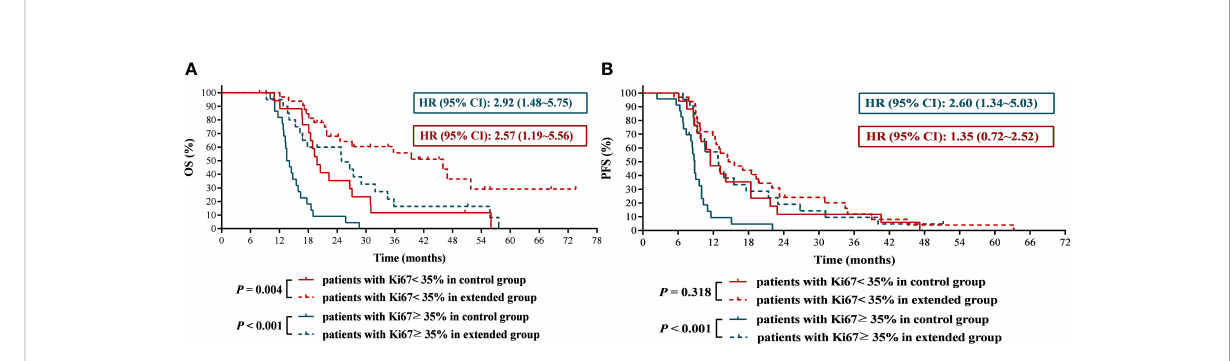
FIGURE 7 The effects of extended adjuvant temozolomide chemotherapy on the clinical outcomes of newly diagnosed glioblastoma patients with different expression level of Ki67. (A) The Kaplan − Meier survival curves for overall survival. (B) The Kaplan − Meier survival curves for progression- free